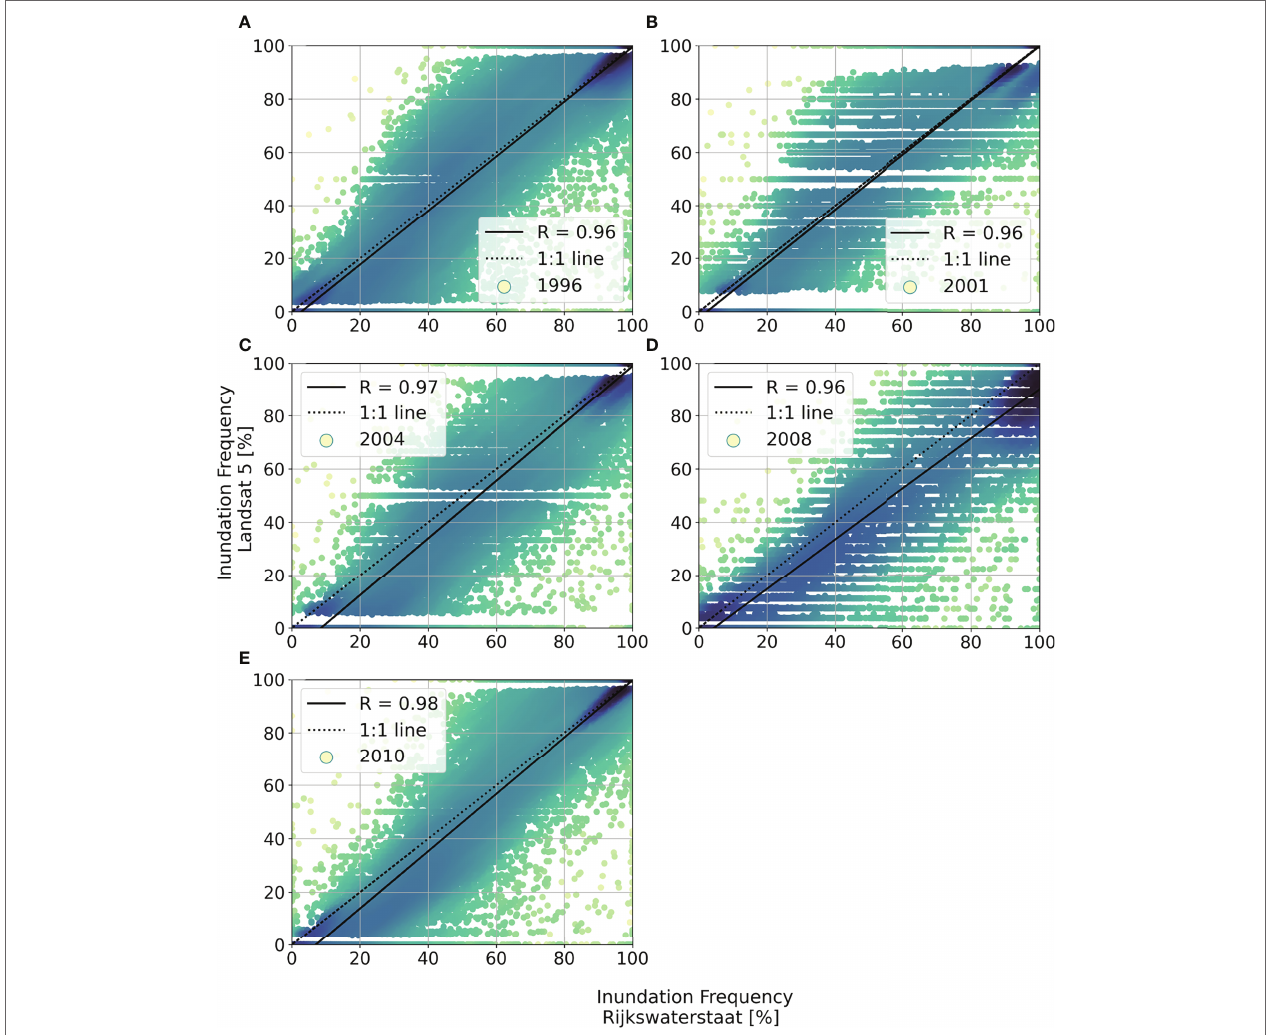
FIGURE 2 | Correlation between inundation frequency [%] provided by Rijkswaterstaat (x-axis) and generated from Landsat 5 TM imagery (y-axis). The color shows the plot density on a logarithmic scale, with darker colors indicating higher densities of